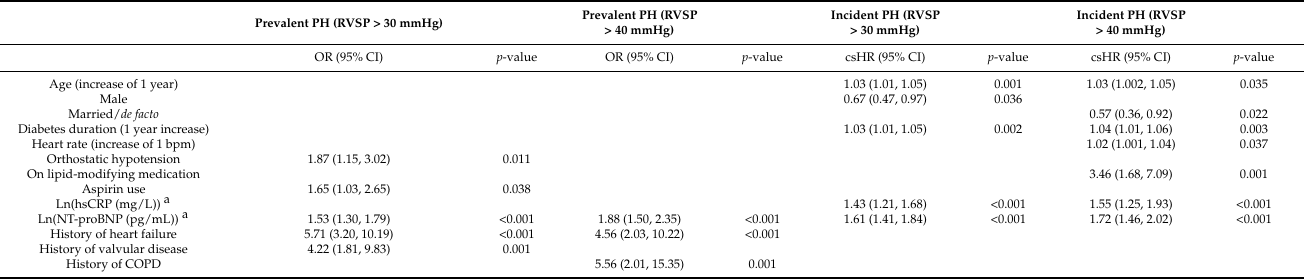
The 92 and 37 participants identified with PH at these thresholds were more likely to be older, have longer diabetes duration, have higher a body shape index (ABSI) as a marker of visceral obesity [22], be taking antihypertensive medications and have lower serum total cholesterol than the remaining 1338 and 1393 participants, respectively, with confirmed type 2 diabetes. Those with prevalent PH also had more atrial fibrillation, cerebrovascular disease, heart failure, higher NT-proBNP, peripheral sensory neuropathy, cardiac valvular disease, history of chronic obstructive pulmonary disease (COPD) and obstructive sleep apnea. The independent associates of prevalent PH under each eRVSP threshold are shown in Table 2. Prevalent PH at eRVSP >40 mmHg was associated with a history of heart failure and COPD and higher levels of NT-proBNP. Prevalent PH at eRVSP >30 mmHg was associated with a history of valvular disease and heart failure, aspirin use, orthostatic hypotension and higher levels of NT-proBNP. Table 2. Independent associates of prevalent and incident pulmonary hypertension (PH). Odds ratios (OR) and 95% CI are shown for prevalent PH and cause-specific hazard ratios (csHR) and 95% CI for incident